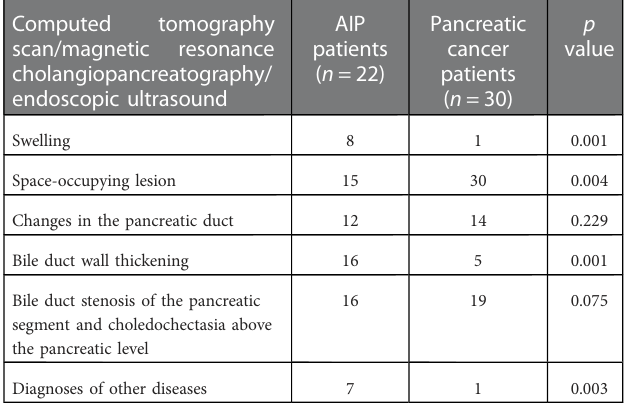
TABLE 4 Radiologic features of AIP patients and pancreatic cancer patients.